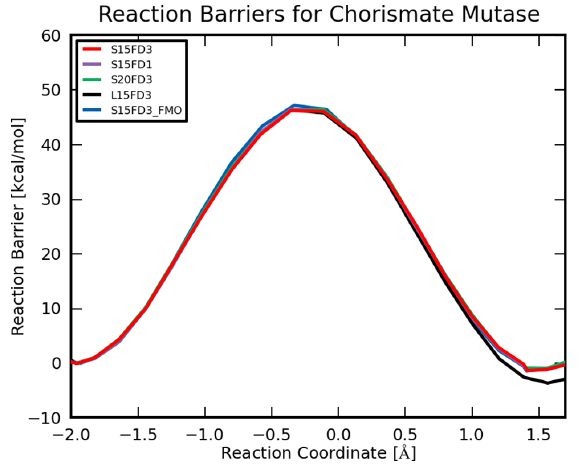
Figure 8. EFMO-RHF/6-31G(d) barrier for chorismate mutase. S15FD3 and S15FD3_FMO are EFMO: S and FMO: S , respectively, both with R resdim ~ 1 : 5 , and the dimer approximation in region b (Equation 11). S15FD1 is similar to S15FD3 but without the dimer approximation in region b . S20FD3 is also similar to S15FD3 but with R resdim ~ 2 : 0 , instead. Finally, L15FD3 is EFMO: L with R resdim ~ 1 : 5 , and the dimer approximation (FDD) in region b .